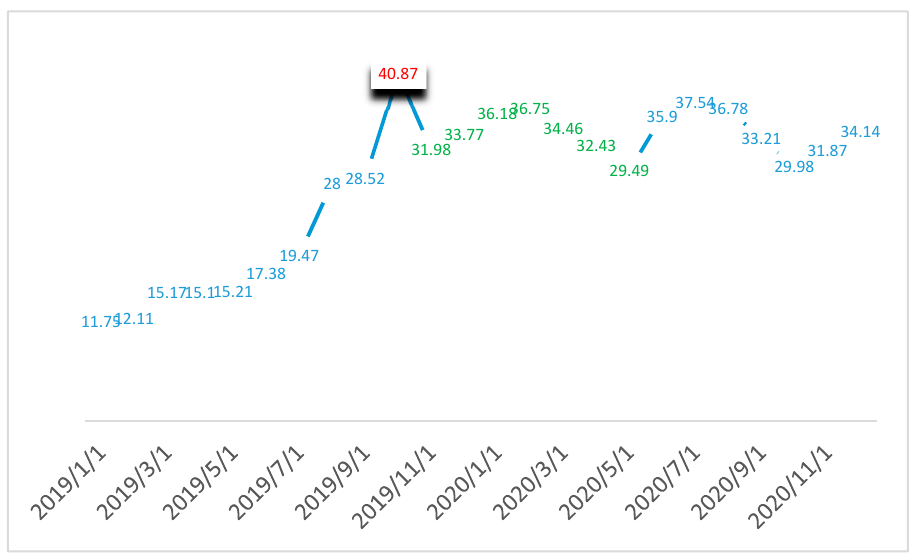
Figure 9. Line chart of monthly fluctuations of China’s live pig prices. Data source: https://zhujia.zhuwang.cc/zhuping.shtml.